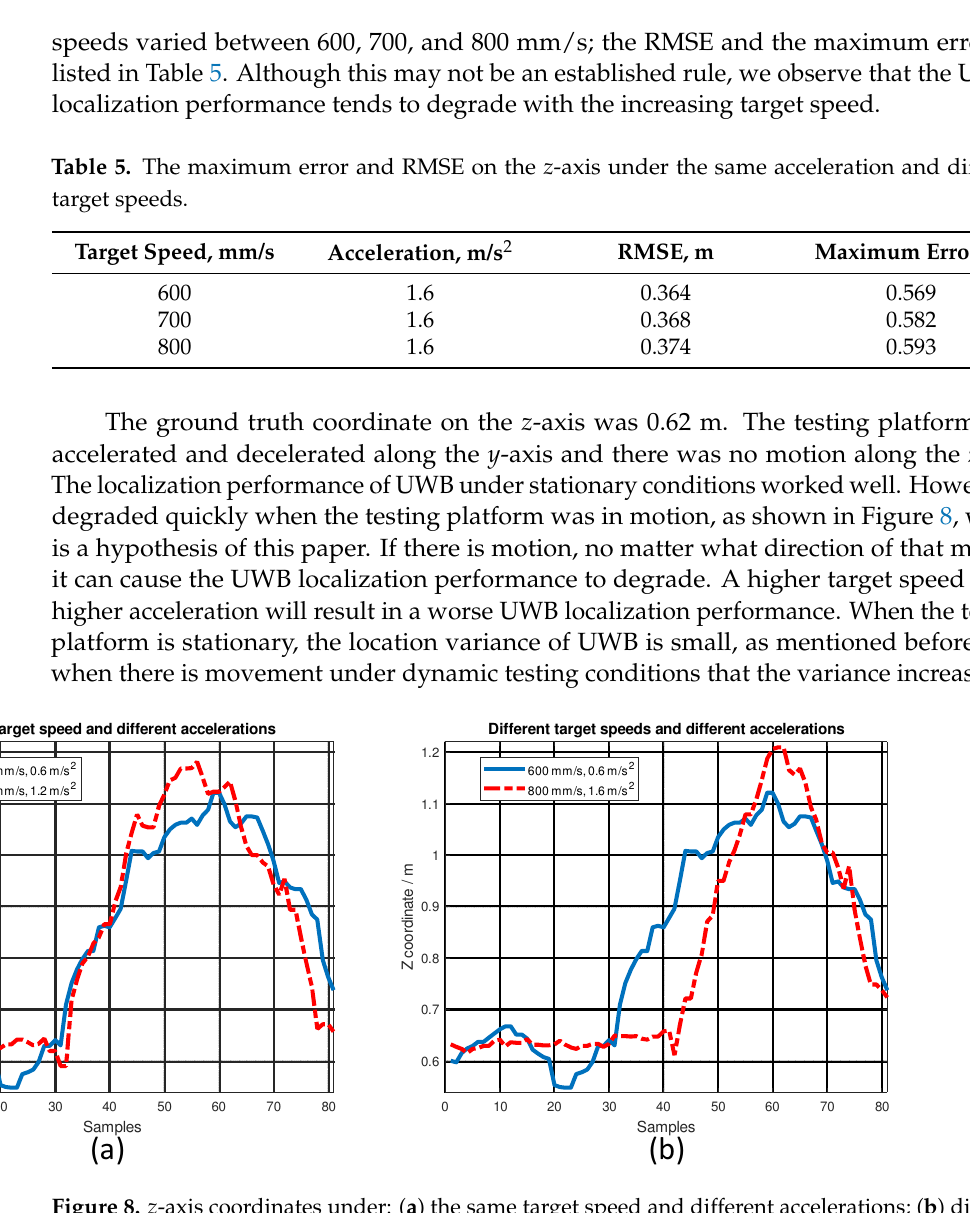
Figure 8. z -axis coordinates under: ( a ) the same target speed and different accelerations; ( b ) different target speeds and different